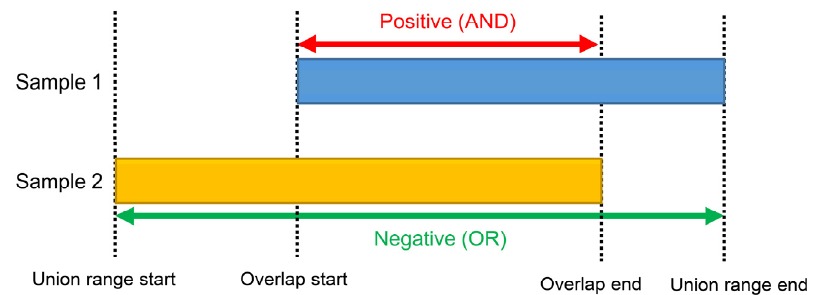
Figure 3. Mode of analysis. enChIP-Seq analyzer extracts overlapped regions (Positive (AND)) as common peak information or eliminates union range regions (Negative (OR)) as negative peak in- formation.